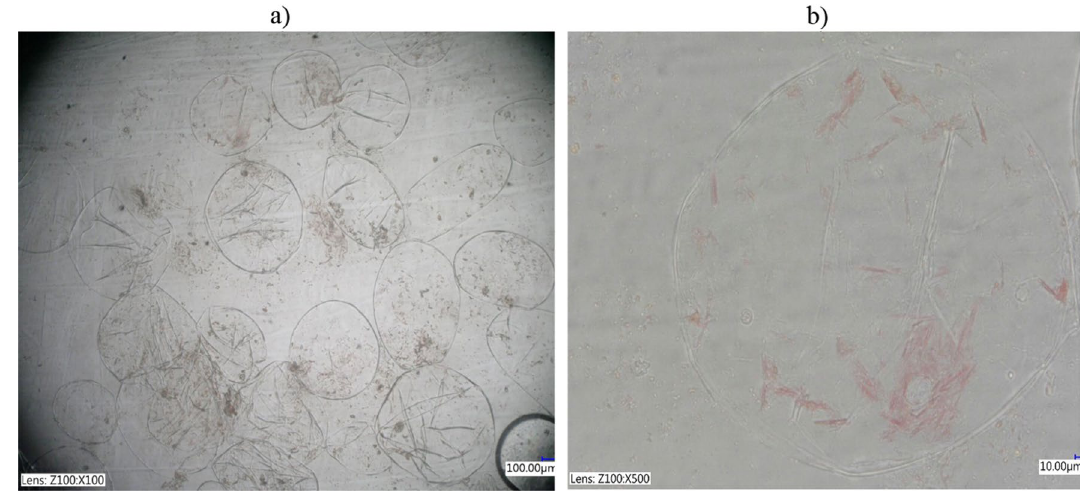
Figure 5. Microstructure of freshly pressed tomato juice at